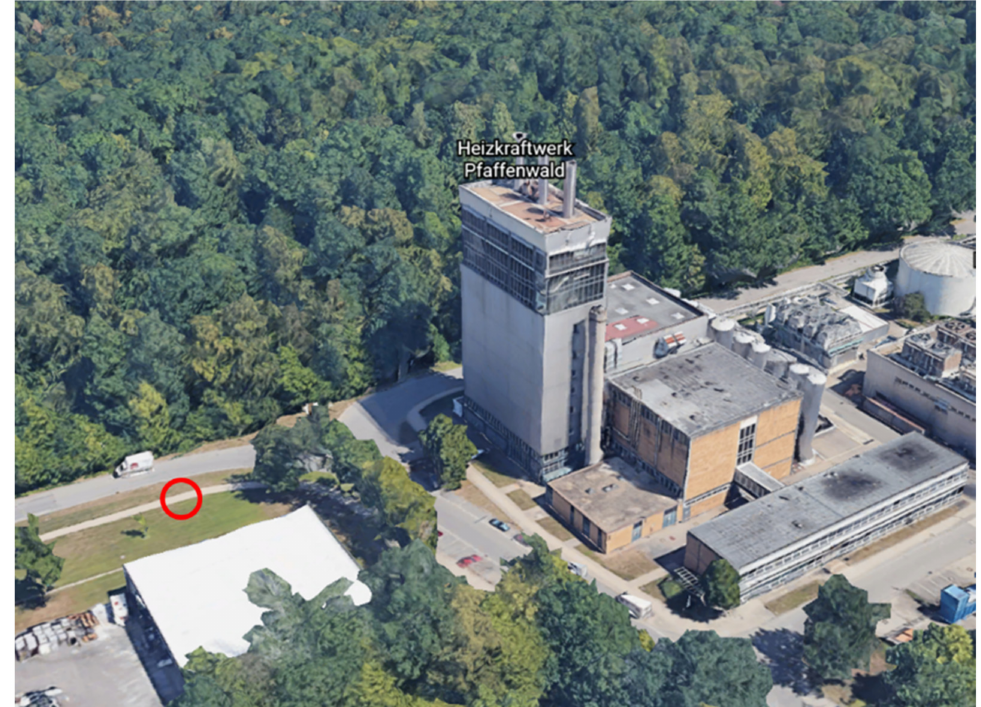
Figure 4. Google Earth image of the field test site showing the power plant of the University of Stuttgart-Vaihingen campus and the UAV take-off location (marked with the red circle).